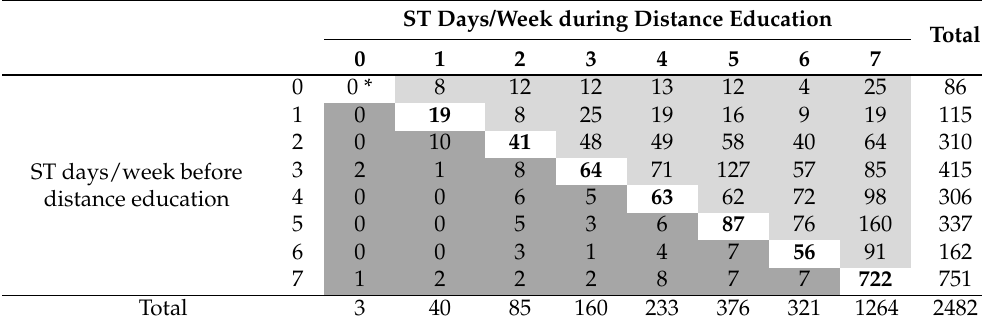
Table 4. Shift table for the level of screen time (ST) before and during distance education. ST Days/Week during Distance